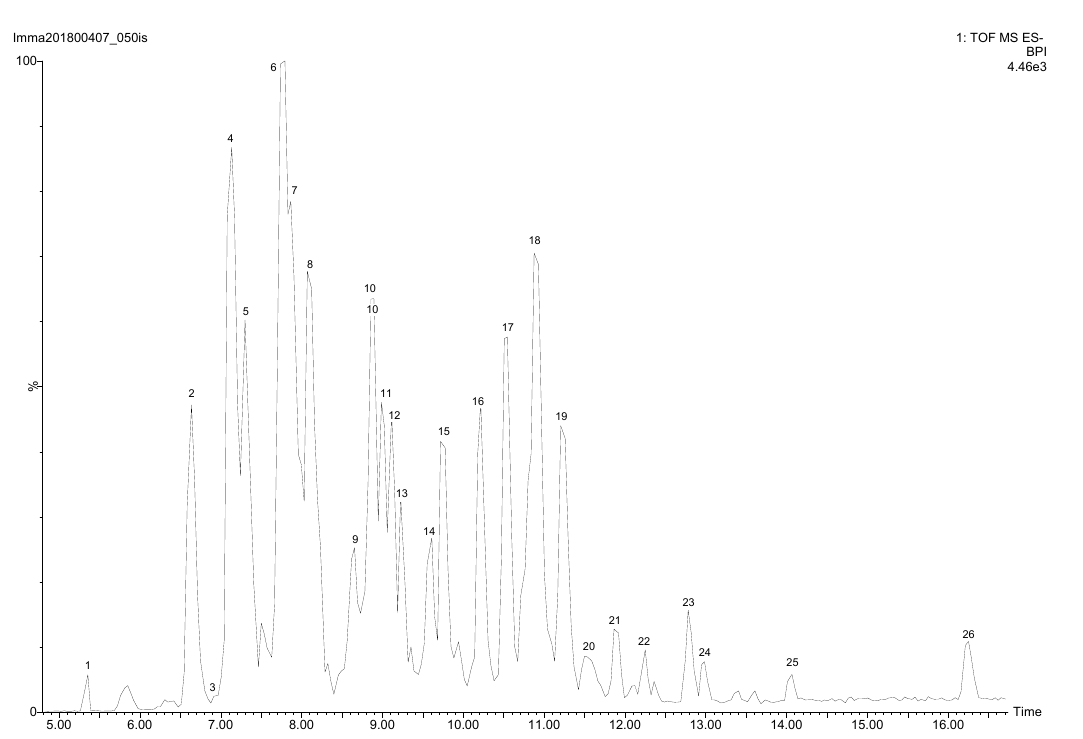
Figure 4. Ethyl acetate fraction Senecio clivicolus base peak intensity chromatogram (BPI).